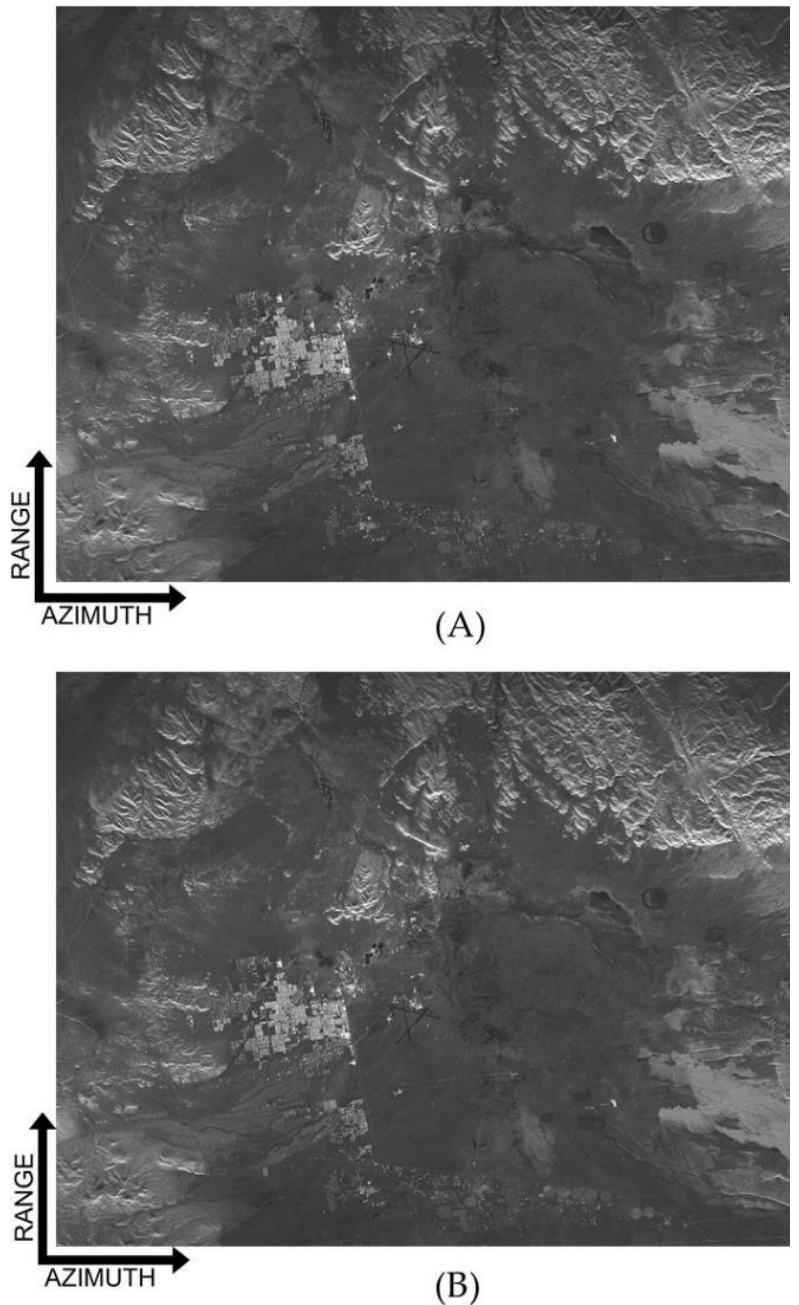
Figure 11. Area of Ridgecrest, California, USA. Amplitude SAR images of the COSMO-SkyMed master (A) and slave (B) acquisitions, acquired on 4 July 2019 and 20 July 2019, respectively.